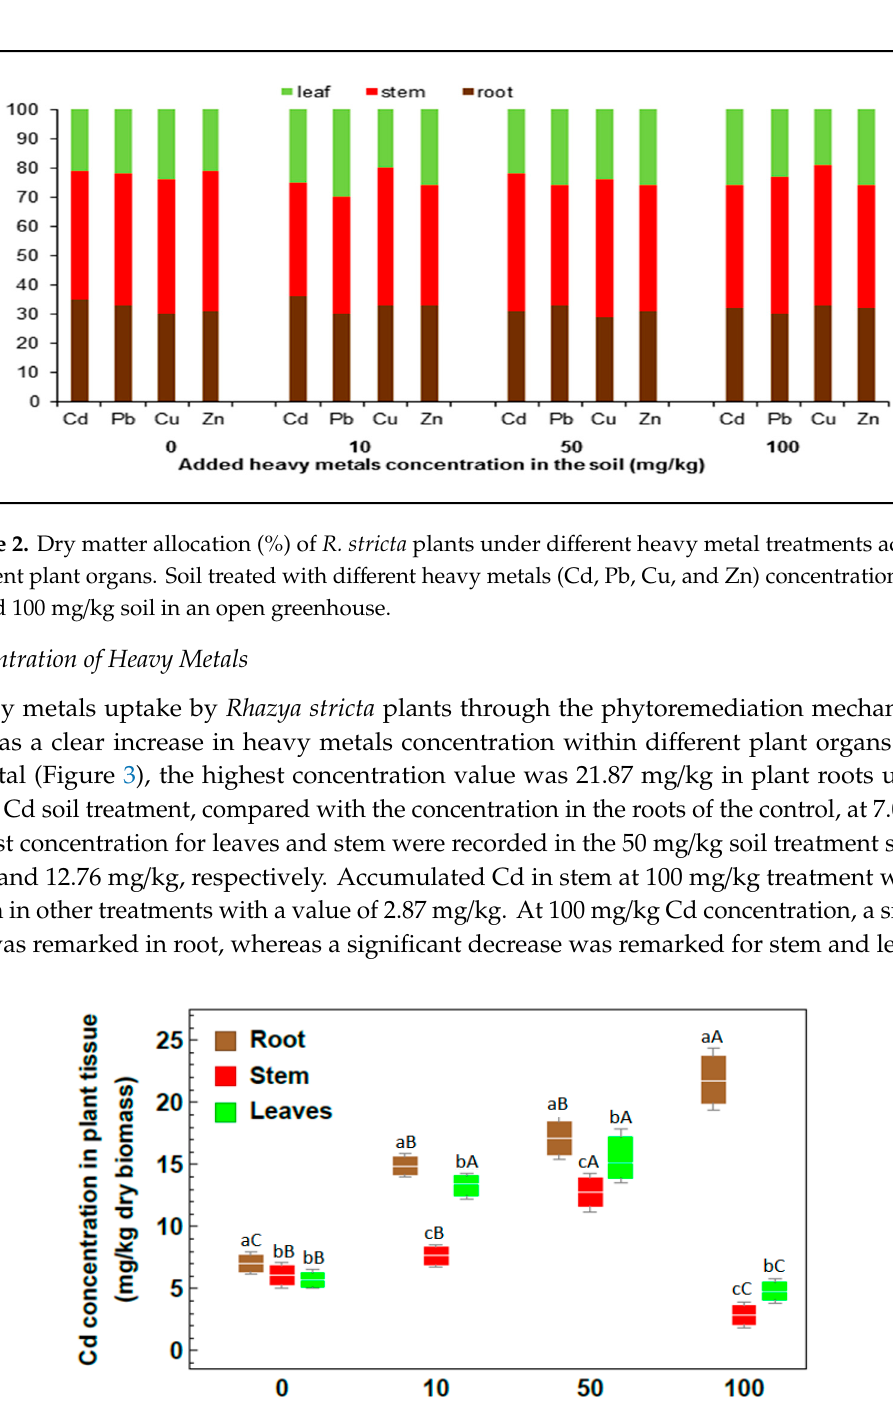
Figure 4. Concentration of Pb in plant organs of Rhazya stricta grown in soil treated with 10, 50 and 100 mg Pb/kg soil in an open greenhouse. Different lowercase letters indicate significant differences between plant parts for each soil metal concentration, and different capital letters indicate a significant difference between soil metal concentrations for each plant part ( p < 0.05). The concentration of Cu by R. stricta depended on the plant organ and the treatment level (Figure 5). The Cu concentration in the roots increased with the increasing level of Cu in the soil and reached 50.10 mg/kg in the 100 mg/kg Cu soil treatment. In both the 50 and 100 mg/kg treatments, the Cu concentration in leaves was higher than that in the stem, while the bioaccumulation value in the stem was higher than that in leaves for plants grown in soil treated with 10 mg/kg Cu.